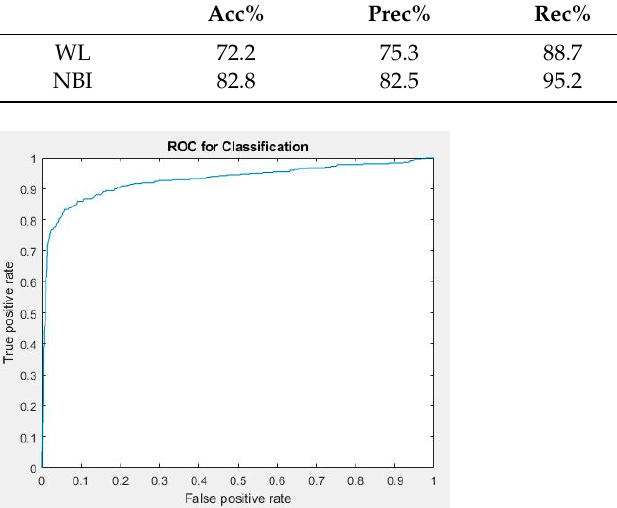
Figure 12. ROC curve for classification. Table 15. Polyp classification dataset.